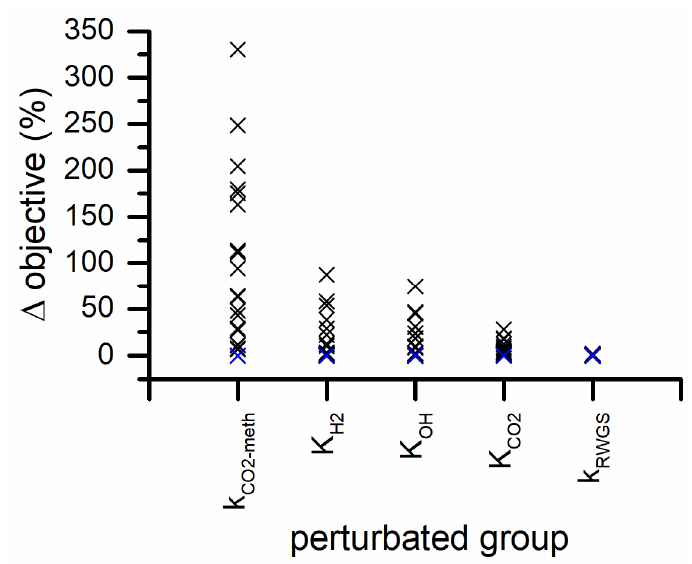
Figure 10. Parameter sensitivity analysis (blue symbols represents 0% variation and the black symbols represent the 5% variation steps).